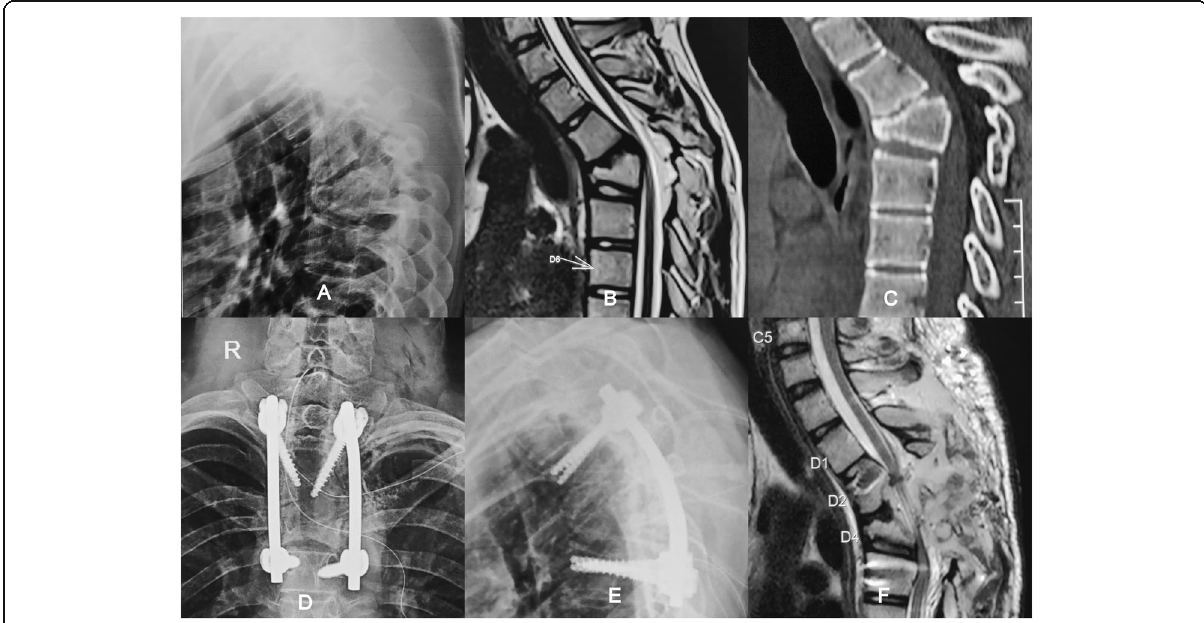
Fig. 1 Index case, 19-year-old male. a Preoperative lateral radiographs showing kyphosis. b , c Preoperative MRI T2-weighted sagittal image and preoperative CT scan sagittal section showing the kyphus with internal gibbus with block vertebra T 3-4-5 . d , e Postoperative anteroposterior and lateral radiographs showing single-segment screw fixation. f Postoperative MRI showing internal gibbectomy done and the decompressed cord. The preoperative status of neurology was mJOA (modified Japanese Orthopaedic Association) score 2; that improved to score 7 at 6 weeks. The duration of surgery was 275 min from induction to extubation. The hospital stay was 6 days. The total blood loss perioperative was 400 ml. Postoperative drain output of 3 days was 470